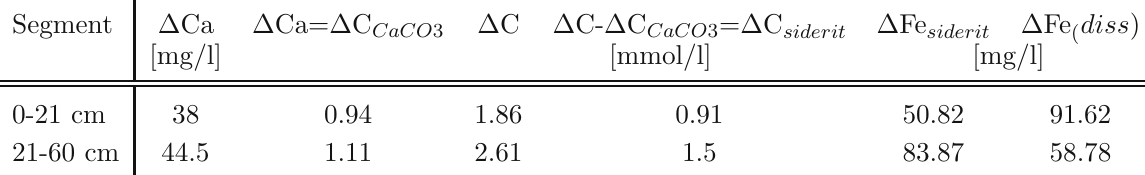
Table 5 Mass balance for dissolved Fe.